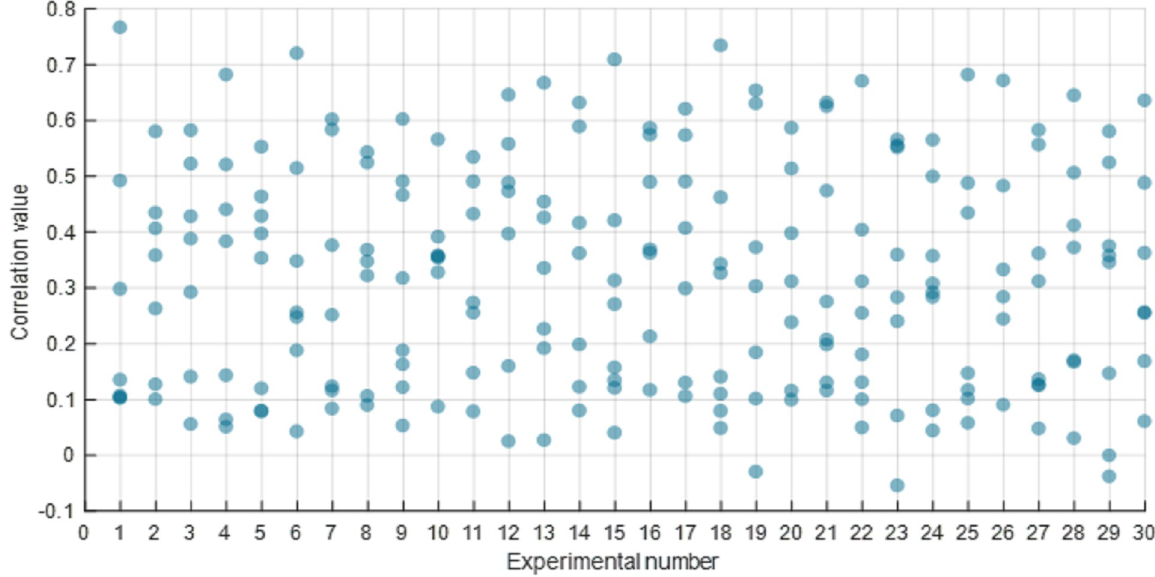
Fig 8. Result of the correlation between the sets of IMFs and raw sEMG signals. The horizontal and vertical axes present the serial number of experiment and the correlation value, respectively.